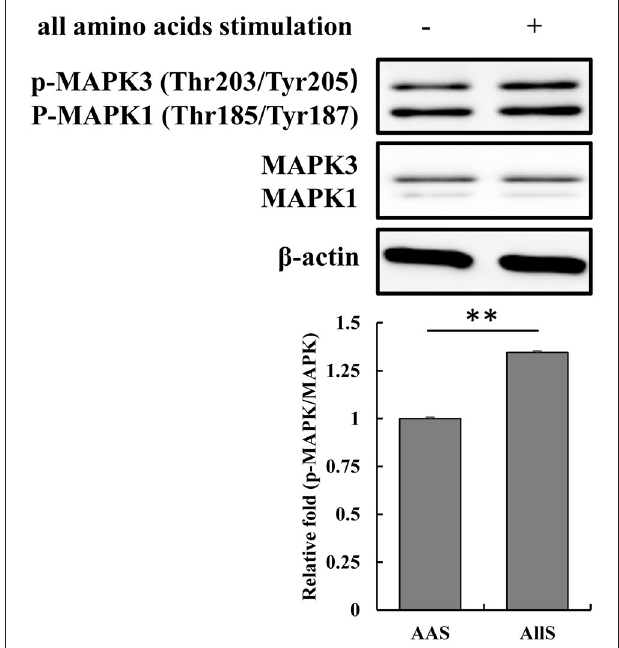
FIGURE 9 | Validation of MAPK3 phosphorylation at threonine 203 and tyrosine 205 during amino acid starvation and restimulation with all amino acids. GFb cells were subjected to amino acid starvation for 1h (AAS group), and restimulation with all amino acids for 1h after amino acid starvation (AllS group). The cells were lysed, and the expression and phosphorylation levels of MAPK3 were analyzed by immunoblotting. Antibodies were derived from rabbits immunized with a synthetic phosphopeptide corresponding to the residues surrounding threonine 202 and tyrosine 204 of human MAPK3, which are identical to the residues surrounding threonine 203 and tyrosine 205 in goat MAPK3. All bands were quantified using Gel-Pro Analyzer 4.0 (* p < 0.05, ** p < 0.01, n = 3